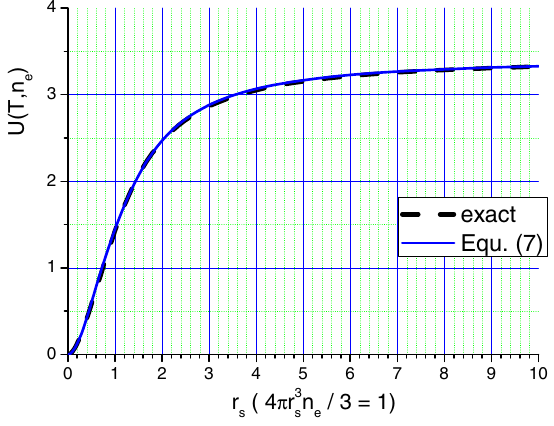
Figure 3. The function U in terms of the scaled electron density at a temperature of 50